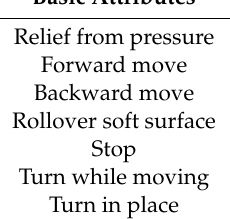
Table 1. Basic skills, the designed wheel chair is capable